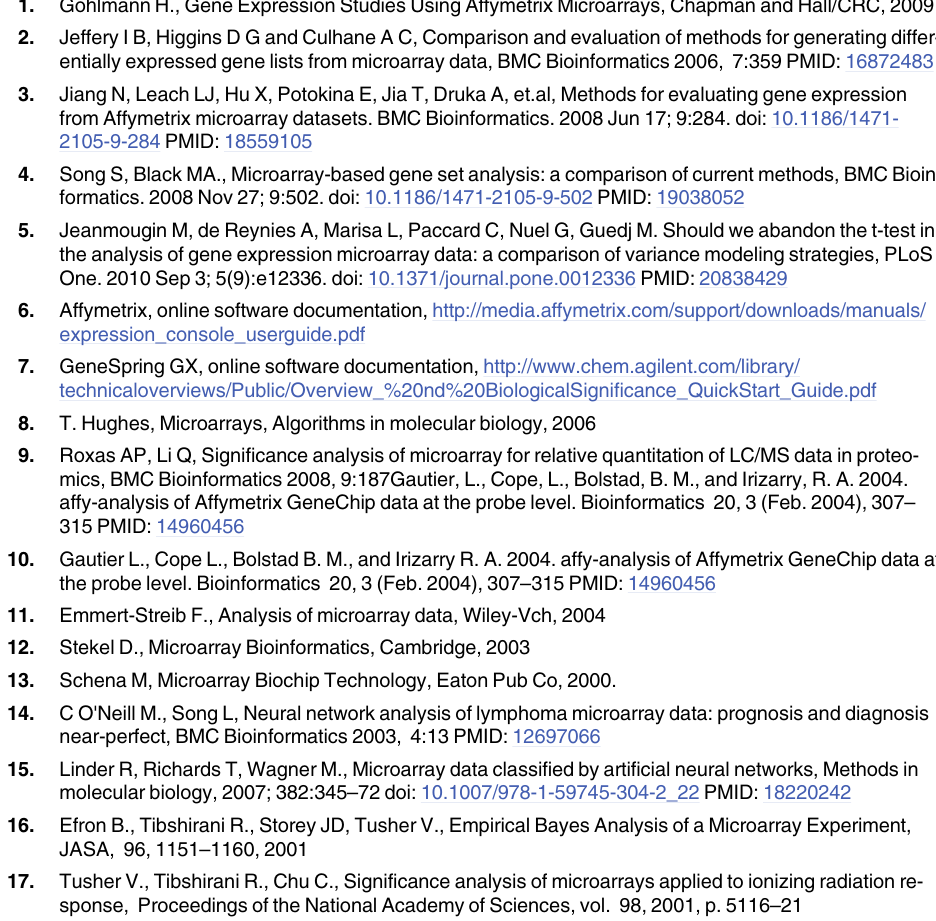
S3 Fig. Venn diagram for Arrayset4. S4 Fig. Venn diagram for Arrayset5. S5 Fig. Venn diagram for Arrayset6. S6 Fig. Venn diagram for Arrayset7. S7 Fig. Venn diagram for